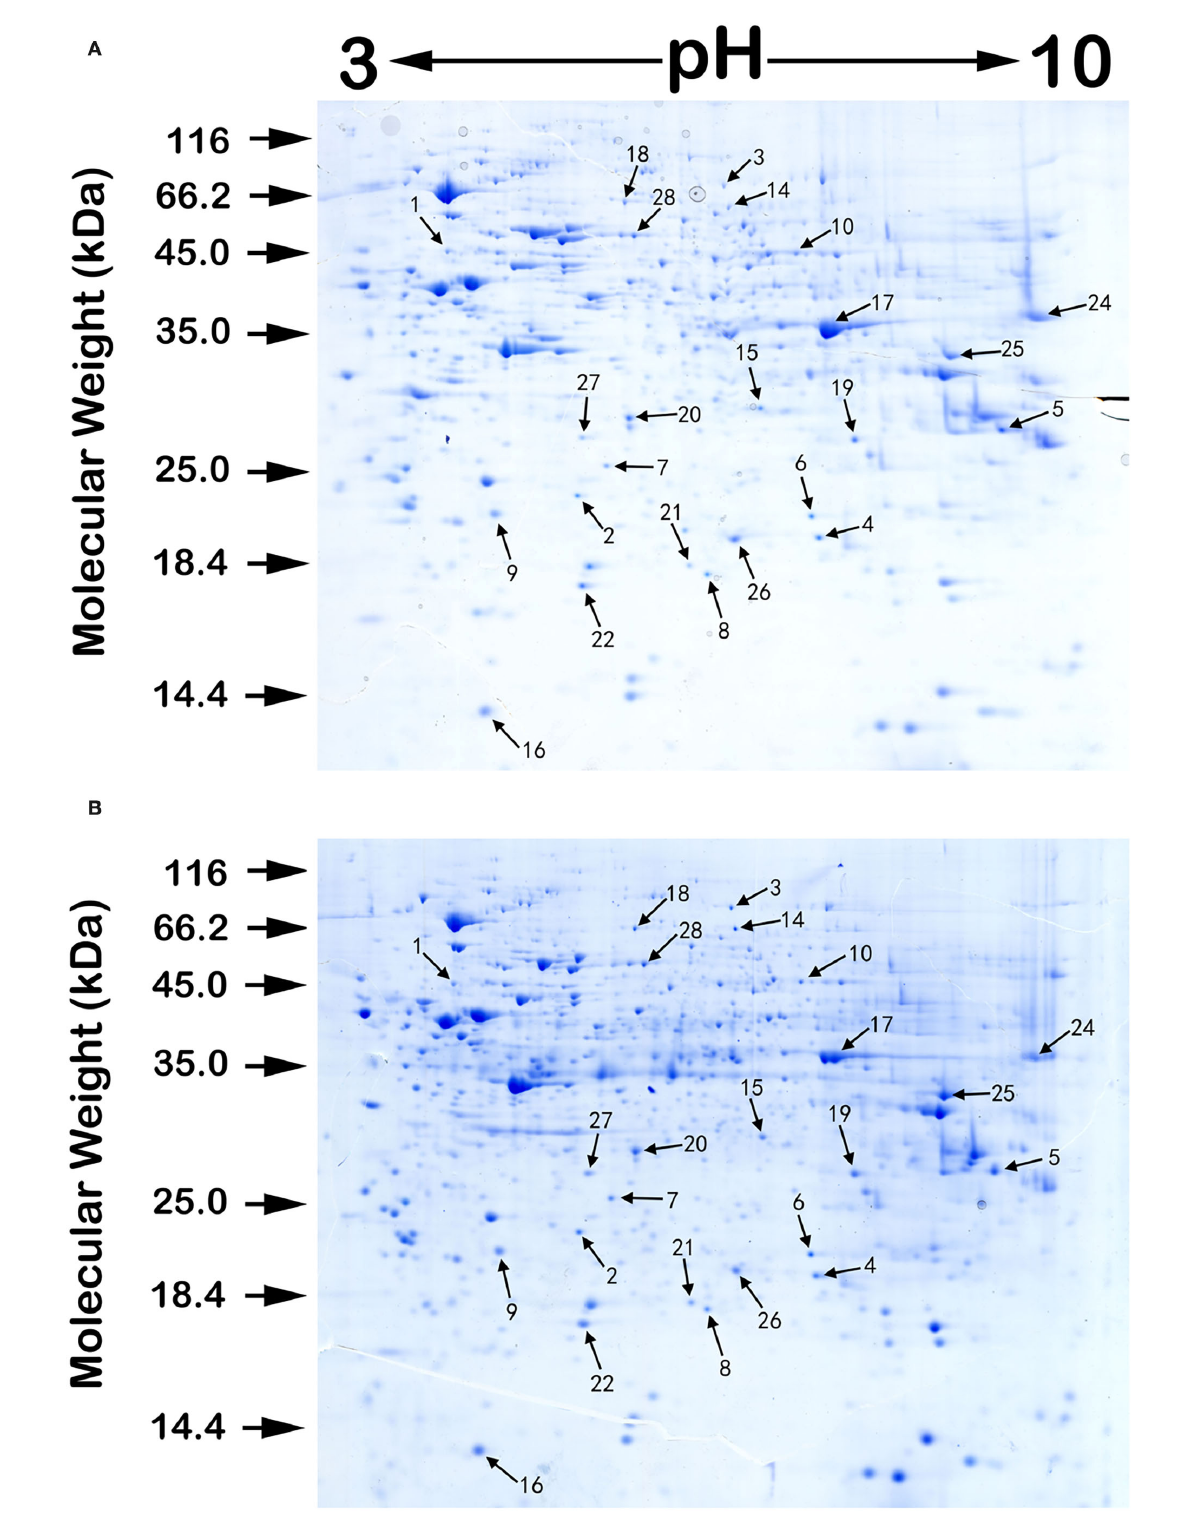
FIGURE2 A pair of protein 2DE images of SW480 cells treated with 5-FU alone (A) and those treated with both 5-FU and curcumin (B) with sample loading of 0.5mg protein each. The isoelectric focusing was carried out on 24cm IPG strips with a nonlinear pH range of 3–10. Then, the proteins in the IPG strips were separated by the second-dimensional SDS electrophoreses. The gels were stained by Colloidal Coomassie blue G-250. Numbers associated with the spots on the gel images refer to the identified proteins listed in Table